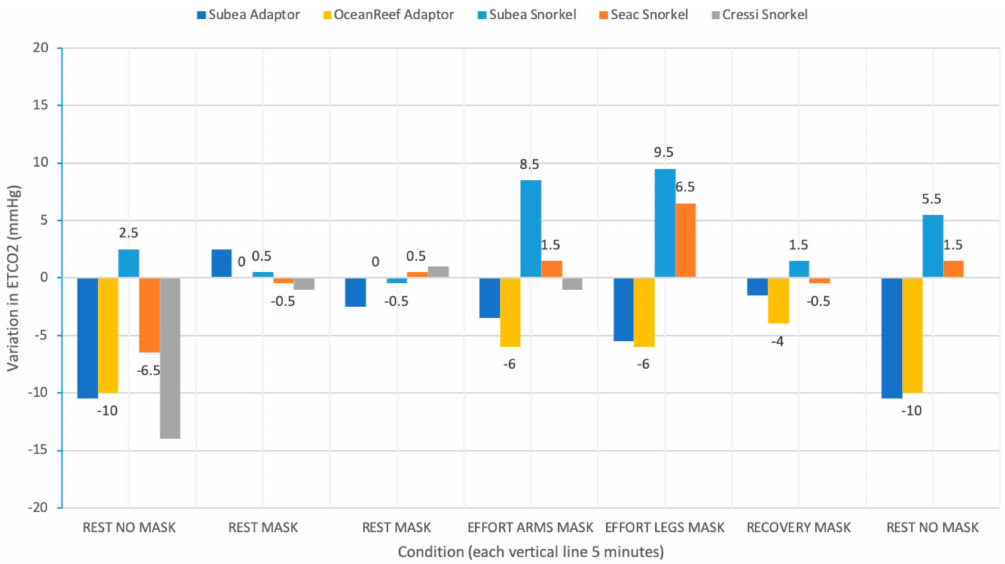
Figure 6. End-tidal CO 2 (ETCO 2 ) variation in various